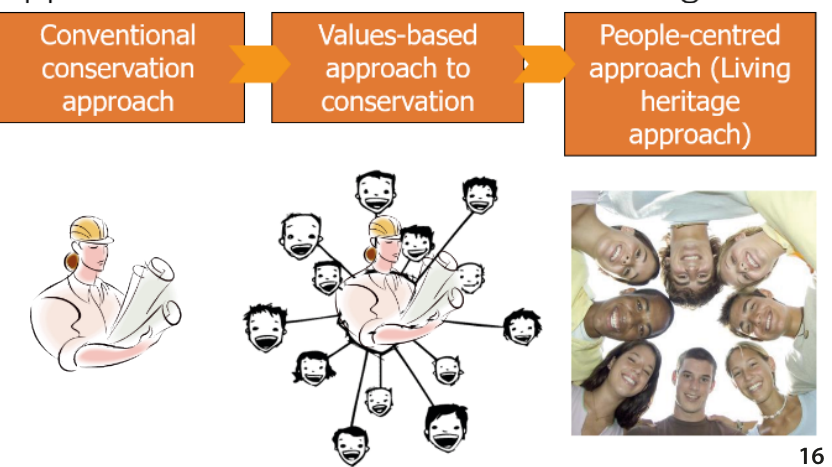
Figure 15 Evolution of approaches to conservation and management (Source: Wijesuriya et al. 2017).